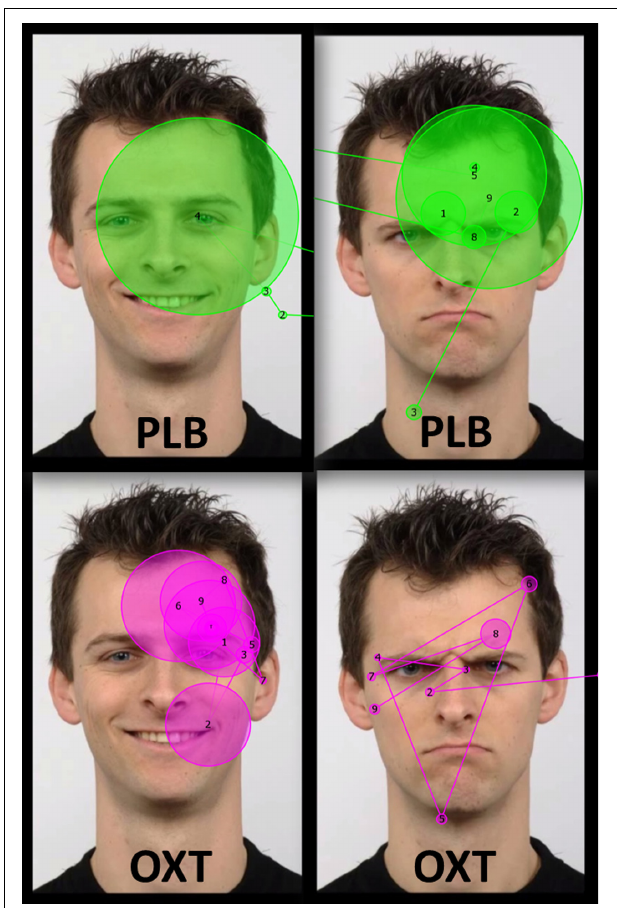
FIGURE 1 | Examples of the stimuli images (from Radboud faces database; Langner et al., 2010) and scan paths of one dog during 7000 ms viewing after the placebo (PLB) and the oxytocin treatments (OXT). The dotted white rectangular area in the top left image represents the analyzed area of interest. Circles represent the gaze fixations of one dog and the lines trace the path that the gaze traveled across the image. Circle size is proportional to the fixation time. The numbers in the circles represent the order of the